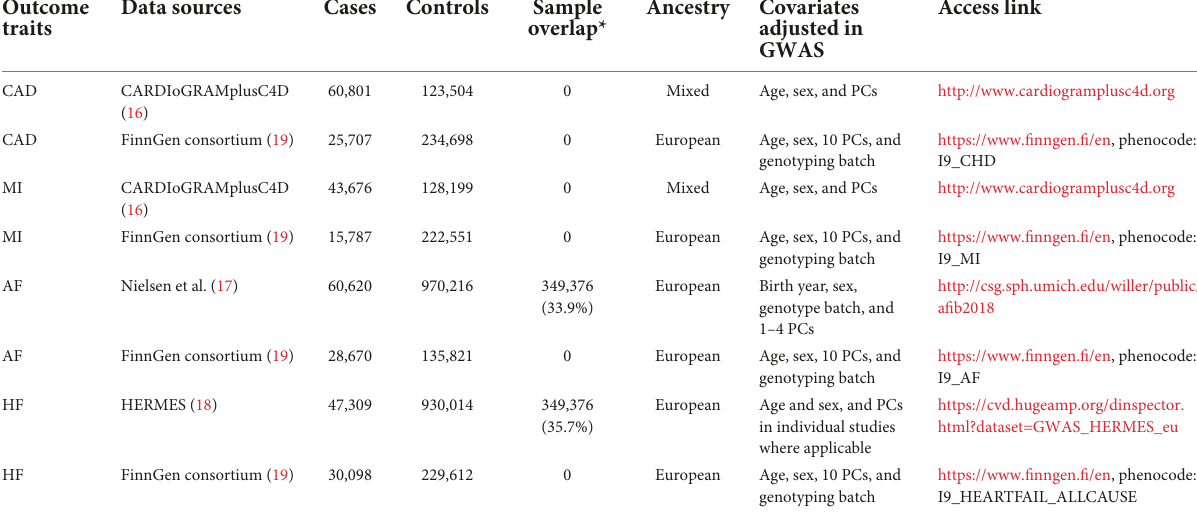
TABLE 1 Descriptions for data sources of CVD outcomes involved in this MR study. Outcome